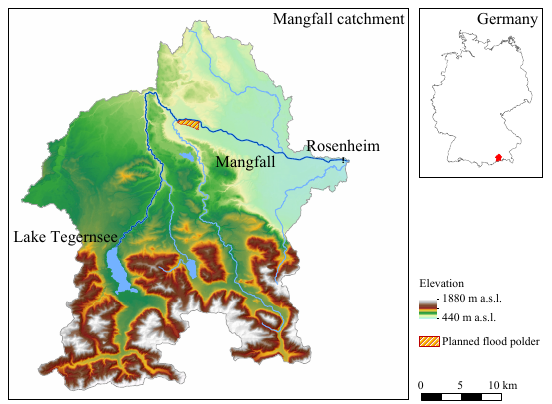
Figure 2. Digital elevation model of the pre-alpine Mangfall catch- ment with its river network. The catchment is characterized by its highly heterogeneous topography leading to different discharge be- havior between the northern and southern regions of the river basin (Geobasisdaten© Bayerische